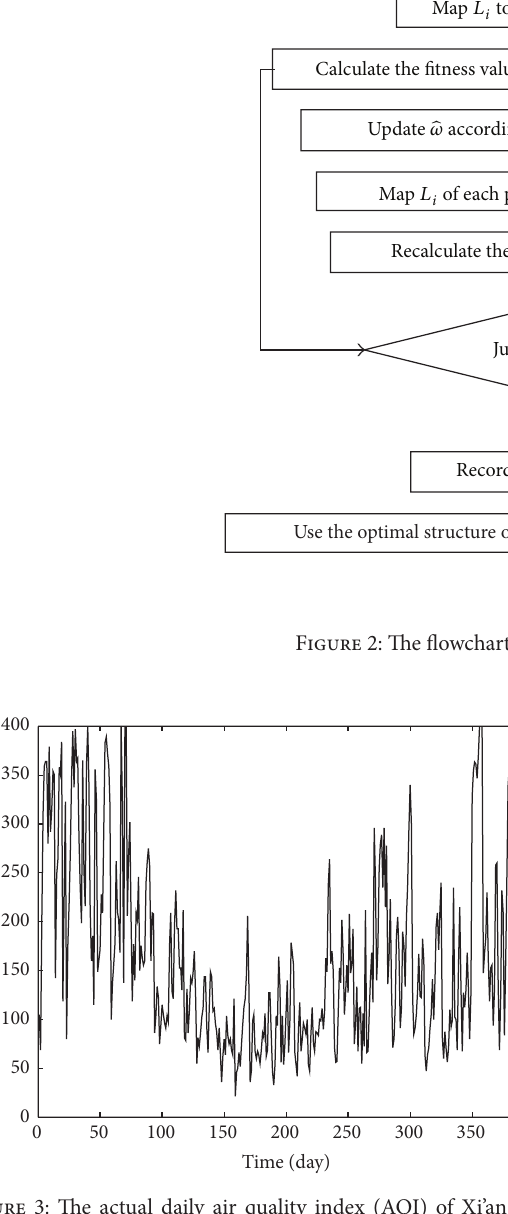
Figure 3: The actual daily air quality index (AQI) of Xi’an from January 2 in 2013 to February 5 in